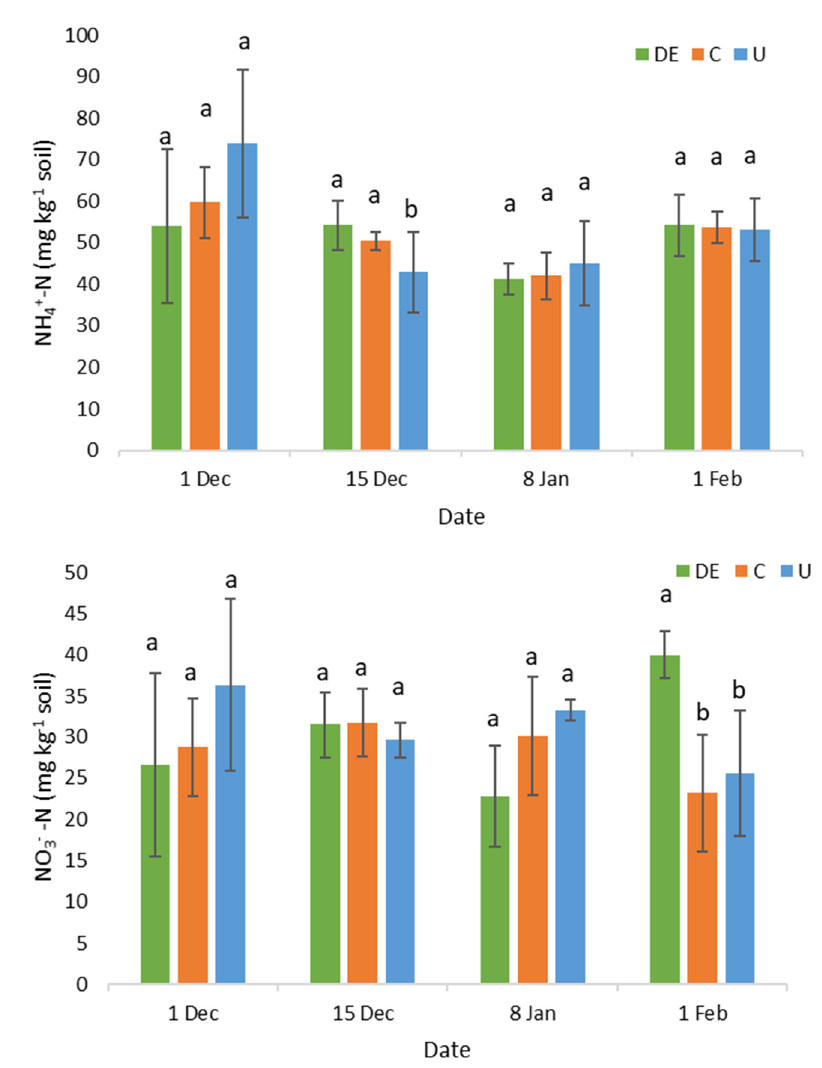
Figure 2. NH 4+ -N ( top ) and NO 3 − -N ( bottom ) levels after fertigation. Different letters indicate significant statistical differences (LSD p < 0.05) within each date. DE: dairy effluent (green); C: control (orange); U: urea (blue).